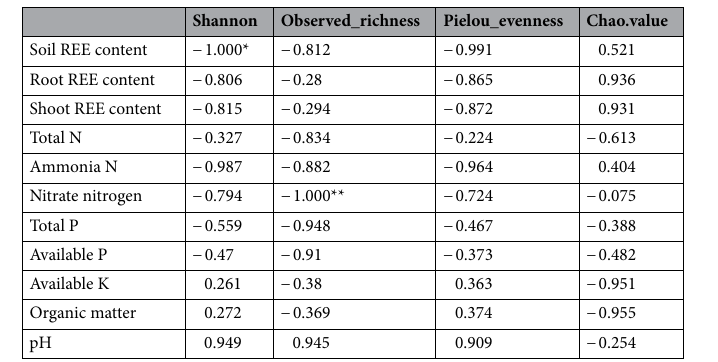
Table 1. Pearson correlation of rare earth element content, soil physical and chemical properties and α-diversity of rice bacteria at tillering stage. **At 0.01 level (two tailed), the correlation was significant, *At 0.05 level (two tailed), the correlation was significant, n =